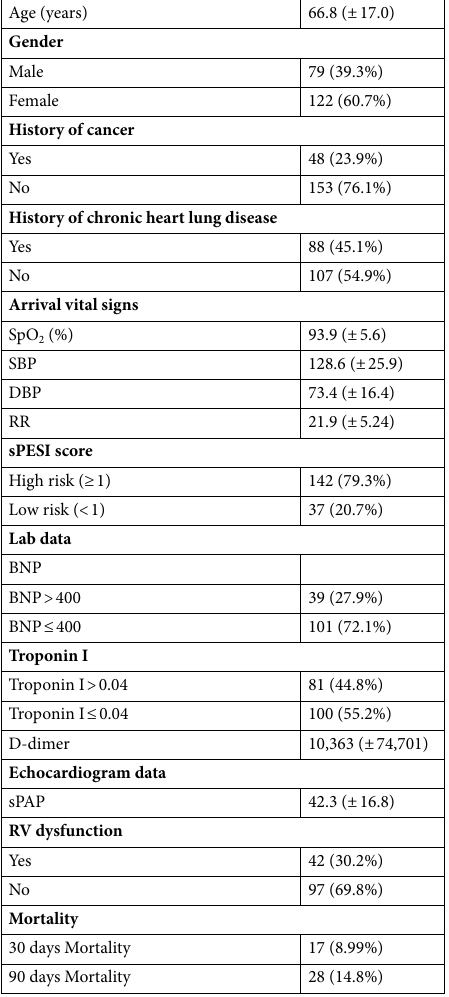
Table 1. Characteristics of the study population. SBP systolic blood pressure, RR respiratory rate, sPAP systolic pulmonary arterial pressure, RV right ventricle, LV left ventricle, RV/LV ratio of diameter of RV and diameter of